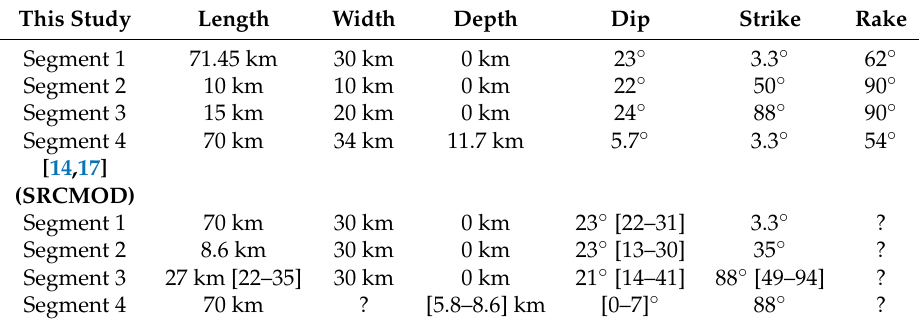
Table 3. Fault geometry parameters used in this study and the ones from Reference